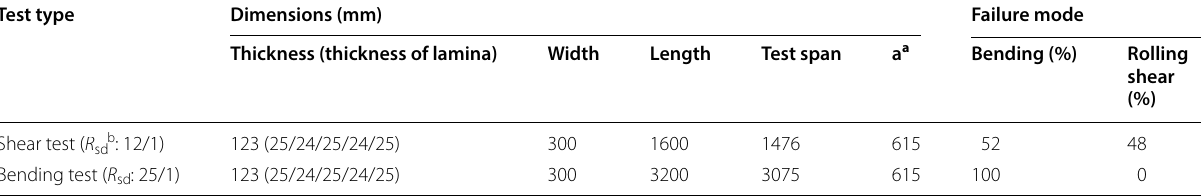
Table 2 Specification and load-carrying capacity of cross-laminated timber